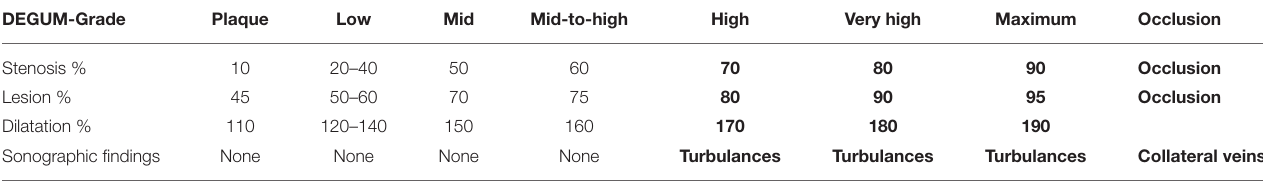
TABLE 2 | Relevant and no relevant